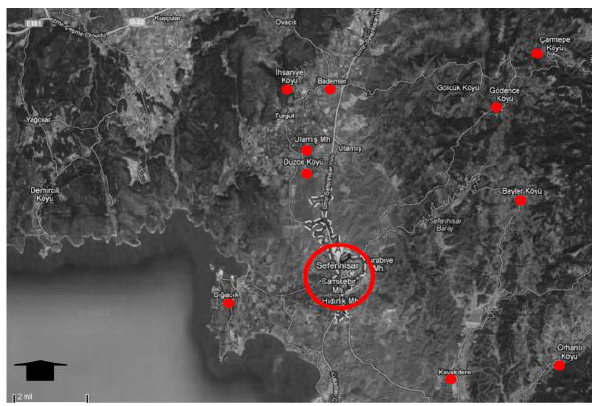
Figure 1. Seferihisar and Its